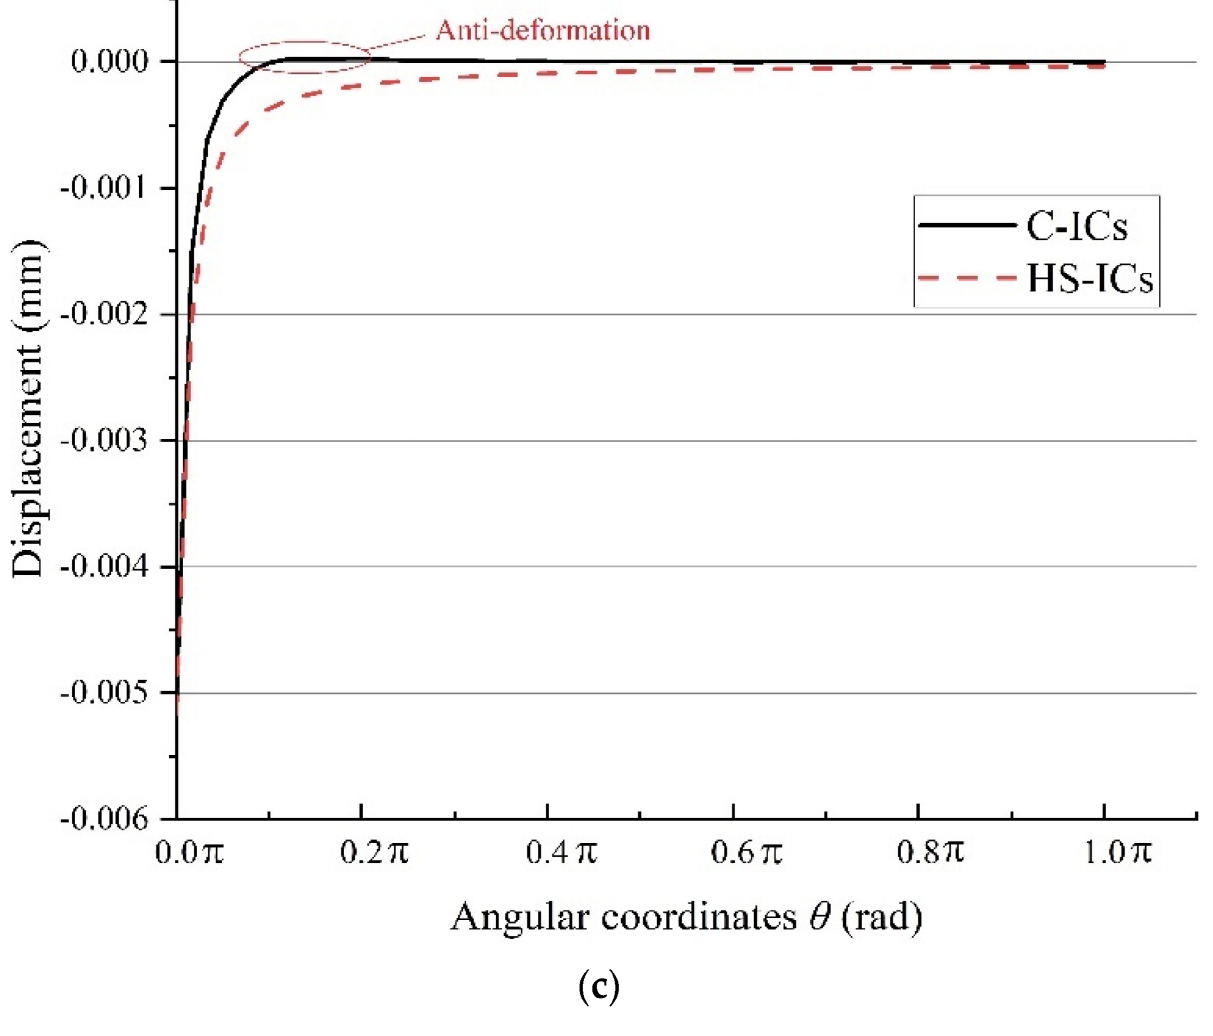
Figure 7. Comparison of different influence coefficient factors: ( a ) the displacement distribution of cylindrical tube subjected to a concentrated force (C-ICs factor); ( b ) the displacement distribution of half-space plane subjected to a concentrated force (HS-ICs factor); ( c ) comparison of displacement distribution at z = 0.